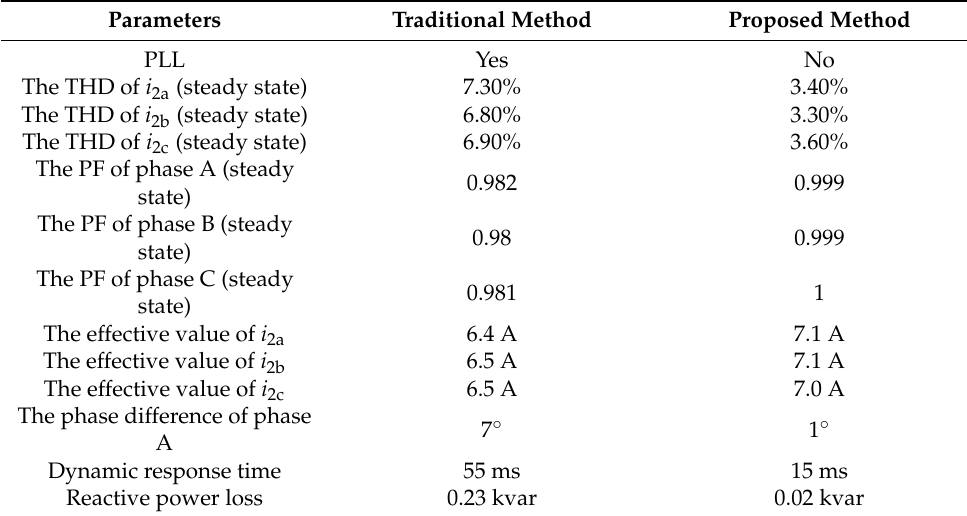
Table 3. Comparison of the experimental